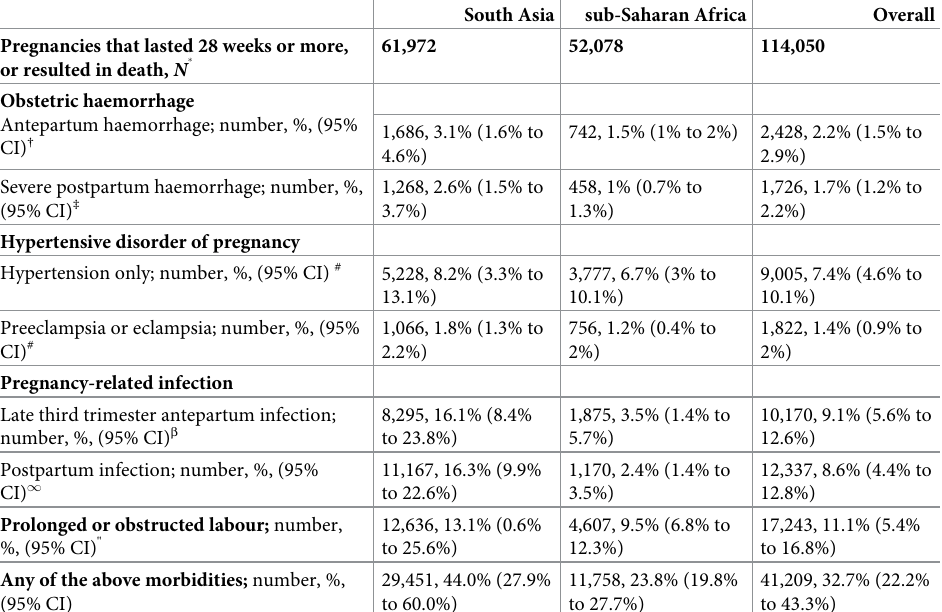
� A total of 183 women lost to follow-up, 92 in South Asia and 91 in sub-Saharan Africa. † Missing data for 101 deliveries in South Asia, 106 in sub-Saharan Africa. ‡ Missing data for 796 deliveries in South Asia, 3,341 in sub-Saharan Africa. # Missing data for 305 deliveries in South Asia, 1,689 in sub-Saharan Africa. β Missing data for 828 deliveries in South Asia, 3,358 in sub-Saharan Africa. 1 Missing data for 795 deliveries in South Asia, 3,312 in sub-Saharan Africa. " Missing data for 834 deliveries in South Asia, 3,332 in sub-Saharan Africa. Missing data for 1,478 deliveries in South Asia, 4,744 in sub-Saharan